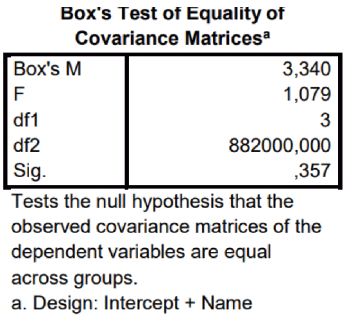
Figure 5. Result of homogeneity test